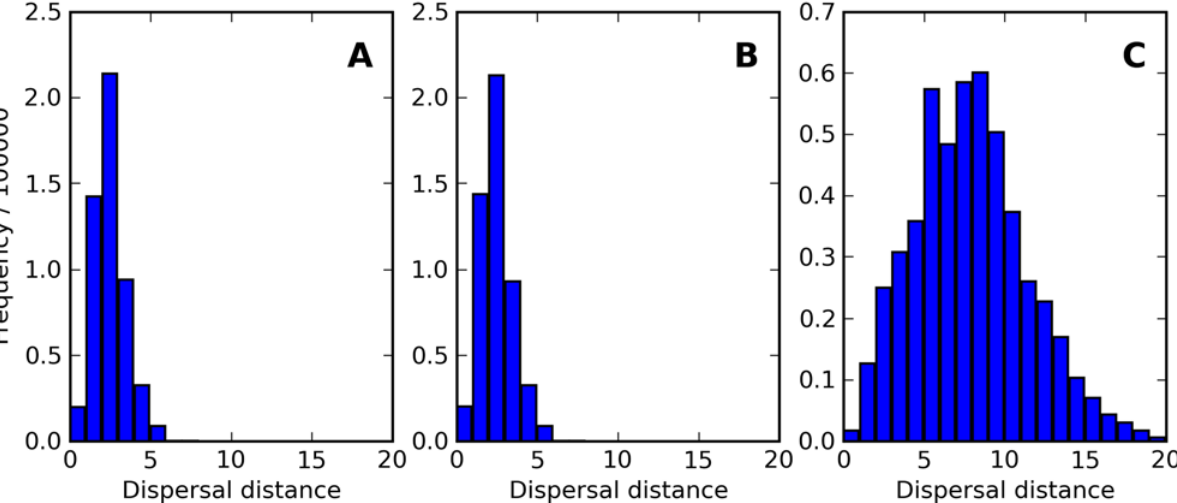
Figure 1. Histograms of Gene Flow Distances. Shown are histograms of the distances traveled, measured as simple Euclidean distance from grid cell center to grid cell center, for all chromosomes in the population within a single representative generation (step 200,000). Three typical simulations were conducted under the following selected simulation parameters: (A) movement distance d =1.5, outbreeding depression threshold h =0.6; (B) movement distance d =1.5, outbreeding depression disabled ( h = + ‘ ); (C) movement distance d =5, outbreeding depression threshold h =0.6. For all graphs, target population size was 128,000, and grid size was 400 6 400. The movement distance parameter d roughly defines the mean distance traveled by individuals in each of three phases within a generation (migration, mate selection, and offspring placement), so the net dispersal distance over a generation was usually greater than d itself.